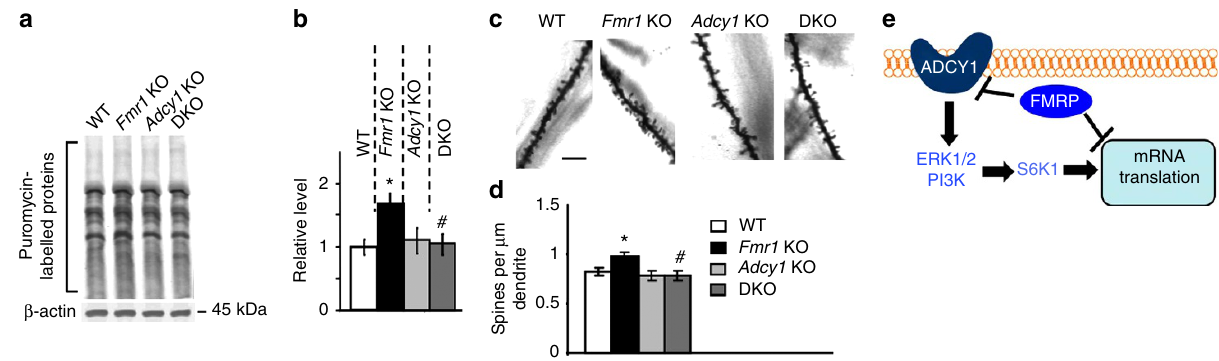
Figure 3 | Genetic removal of Adcy1 normalizes cellular abnormalities in Fmr1 KO mice. ( a ) Newly synthesized proteins in primary hippocampal neurons from WT, Fmr1 KO, Adcy1 KO and DKO mice were labelled by puromycin, and detected by anti-puromycin antibody. ( b ) The intensity of protein bands between 15 and 250kDa was quantified and normalized to the level of b -actin. ( c ) Golgi staining of dendritic spines on apical dendrites in the CA1 area of WT, Fmr1 KO, Adcy1 KO and DKO mice (length of the scale bar, 10 m m). ( d ) Quantification of total spine number on the CA1 apical dendrites. ( e ) A working model illustrates the function of FMRP-dependent suppression of Adcy1 translation in controlling intracellular signalling and neuronal protein synthesis. *: significant difference between WT and Fmr1 KO group ( P ¼ 0.018 in b ; P ¼ 0.025 in d ). # : significant difference between Fmr1 KO and DKO group ( P ¼ 0.041 in b ; P ¼ 0.038 in d ). The P -values were determined by post-hoc LSD test following ANOVA analysis ( n ¼ 6 for each group, F 3,20 ¼ 4.175, P ¼ 0.019 in b ; n ¼ 4 for each group, F 3,12 ¼ 3.827, P o 0.03 in d ). Data are presented as mean ± s.e.m.